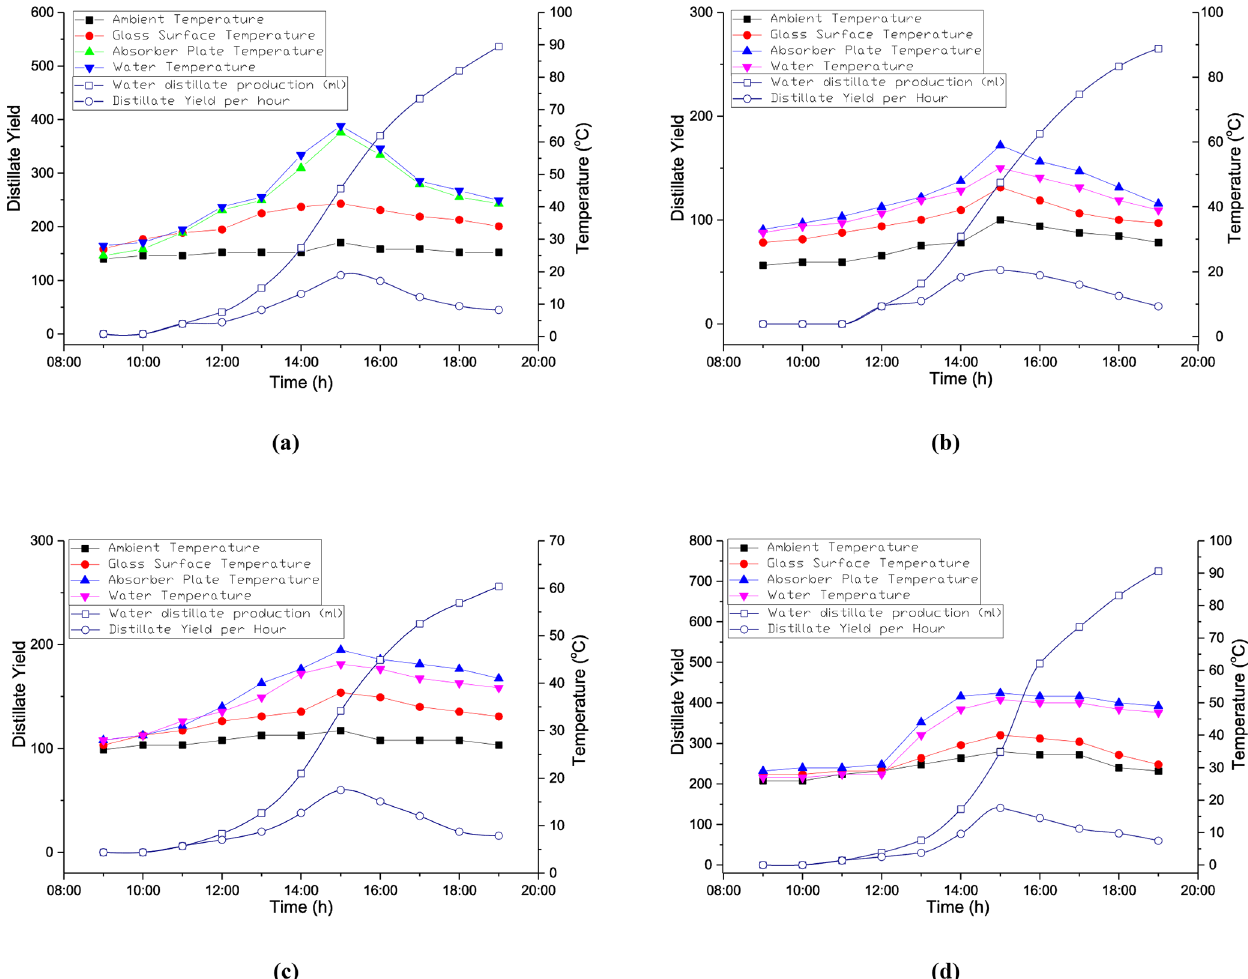
Figure 4. Influence of temperature on distillate yield. (a) Day 1, (b) day 3, (c) day 6, and (d) day